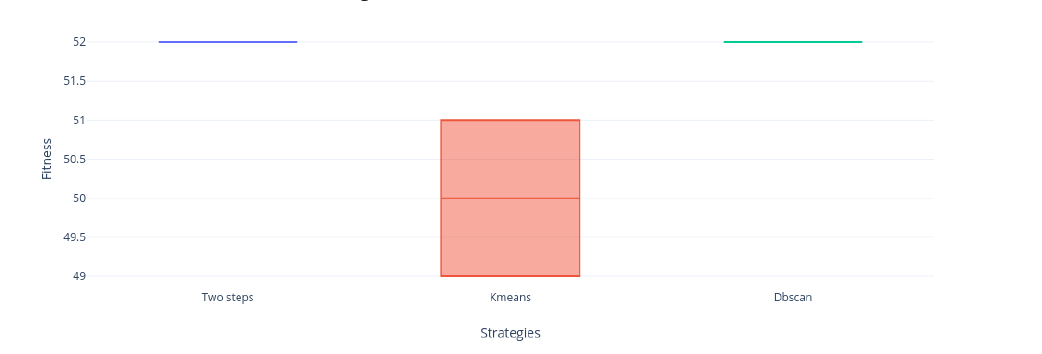
Figure 21. Instance f5 distribution.